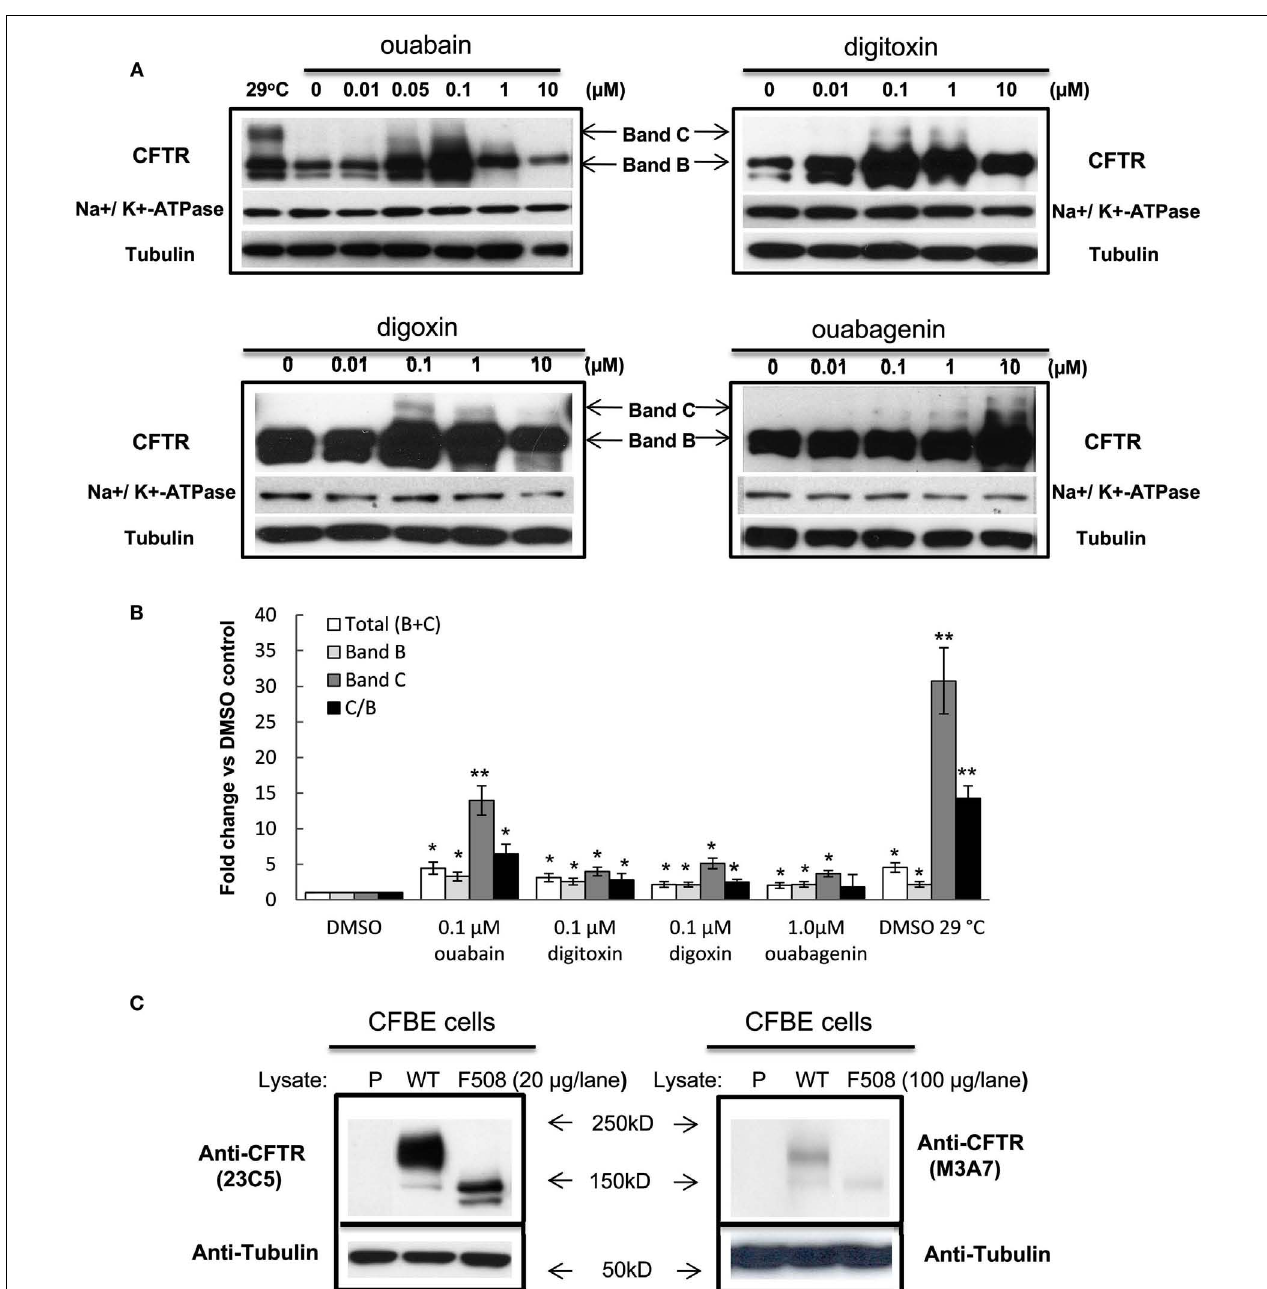
change vs. DMSO control.Values in the experiments described are presented as means ± SD ( n = 3). Means were tested for statistical significance using a Student’s t -test (* P < 0.05; ** P < 0.01). (C) The cell lysates from parental CFBE41o- (P), CFBE/WT-CFTR (WT), and CFBE/F508del-CFTR (F508) cells were analyzed using anti-CFTR antibody 23C5 (our own anti-CFTR antibody) or M3A7 (from Chemicon).The molecular weight (kDa, kilodalton) of the markers was shown on the side of the